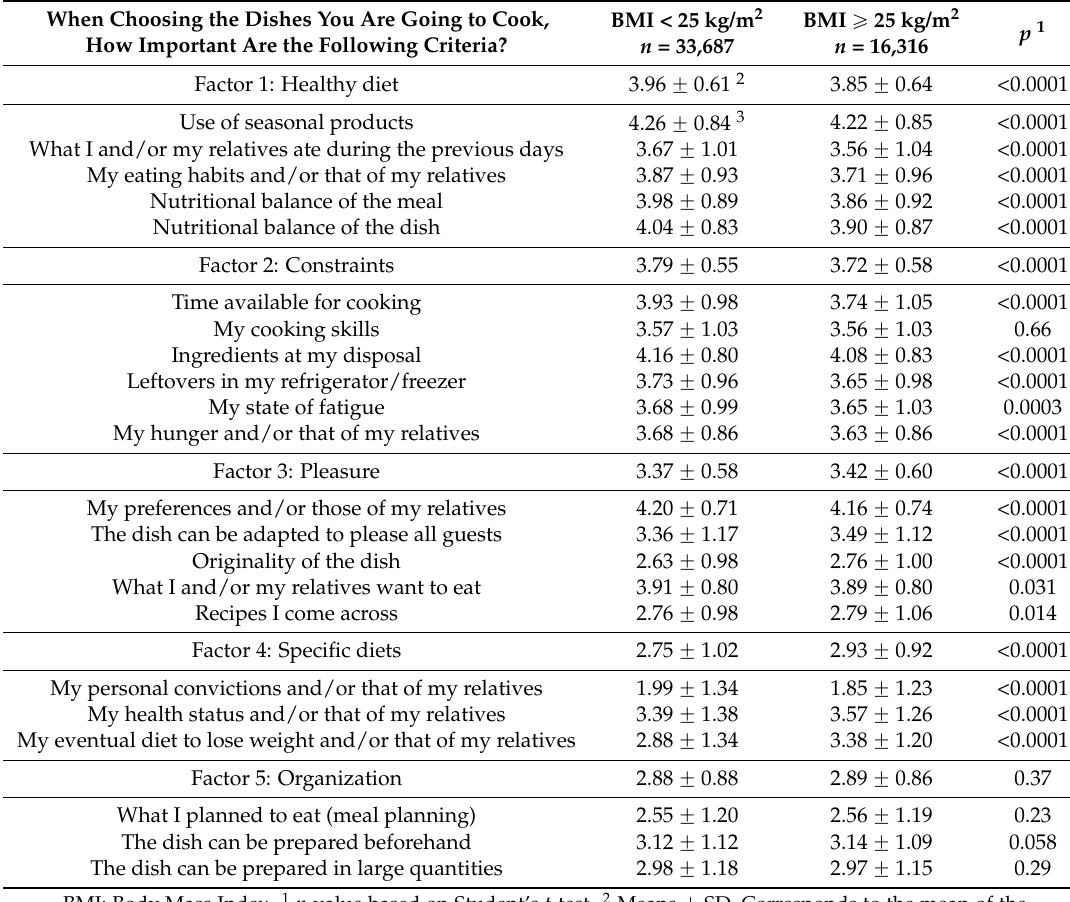
Table 2. Mean ratings of the 27 dish choice motives and the five factors emerging from the exploratory factor analysis in overweight and non-overweight participants ( n = 50,003; NutriNet-Santé study 2013).